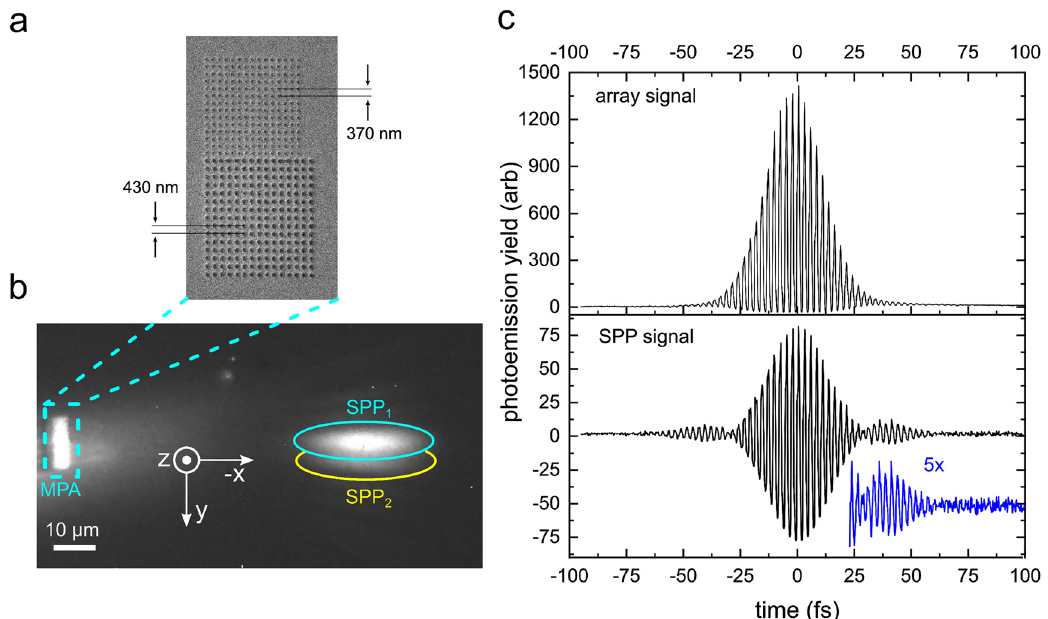
Figure 3: Amplitude modulation of an surface plasmon polariton (SPP) wave packet. (a)Scanningelectronmicrographof amultiperiodicarraycomposedof adjacent2DphotonicBragggratings(2PG)ofdifferentpitches.b)Two- photonphotoemission(2PPE) snapshotof referenceSPP after 70 µm of propagation. The orientation of the multiperiodic array (MPA)(dashed box) is as pictured in a. (c) Interferometric autocorrelation traces for signal originating at the array and signal derived from SPP overlap 70 microns from the array.